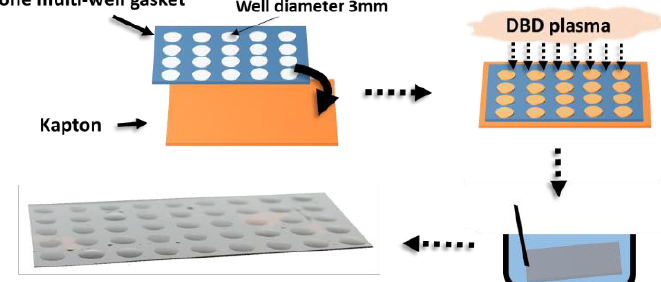
Figure 5. Schematic representation of the step used for the fabrication of Kapton surface with wettability patterns using a silicon multi-well gasket and DBD plasma and photography of resulting array of water droplets.